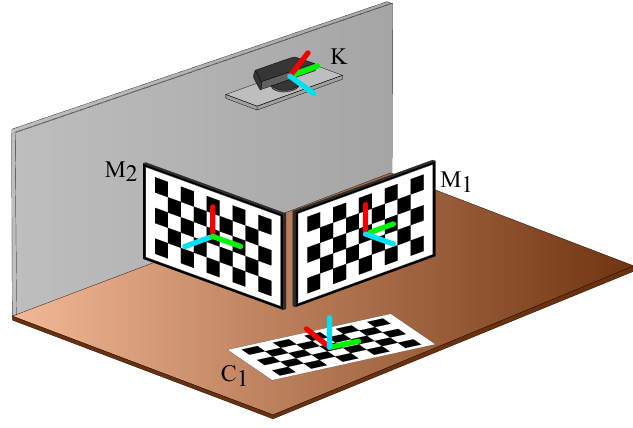
Fig. 3. The calibration rig. K is the tracking device, M 1 and M 2 are two 3D monitors, on which virtual chessboards are rendered, and C 1 is a real